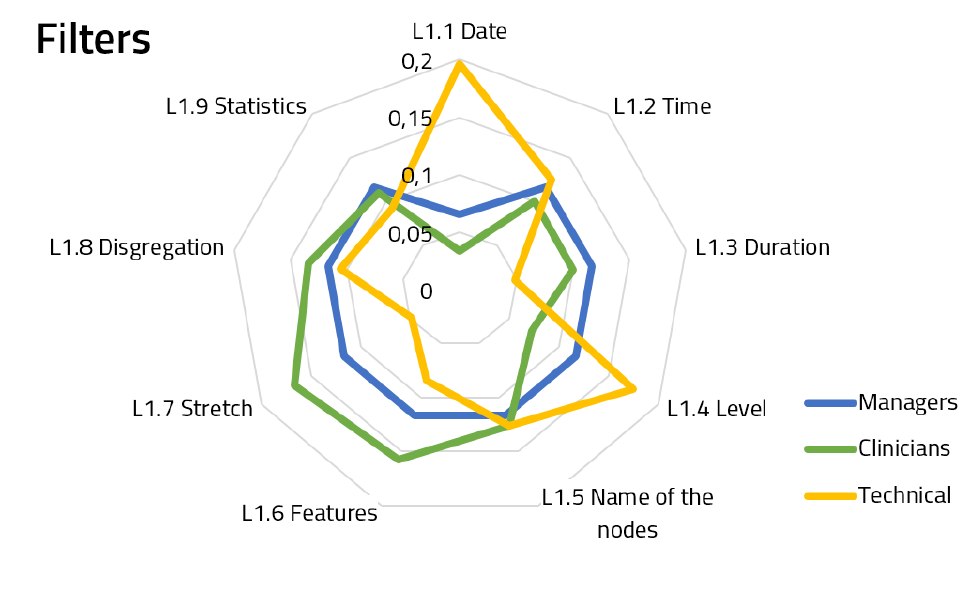
Figure 5. Priorities for filter functional module features.